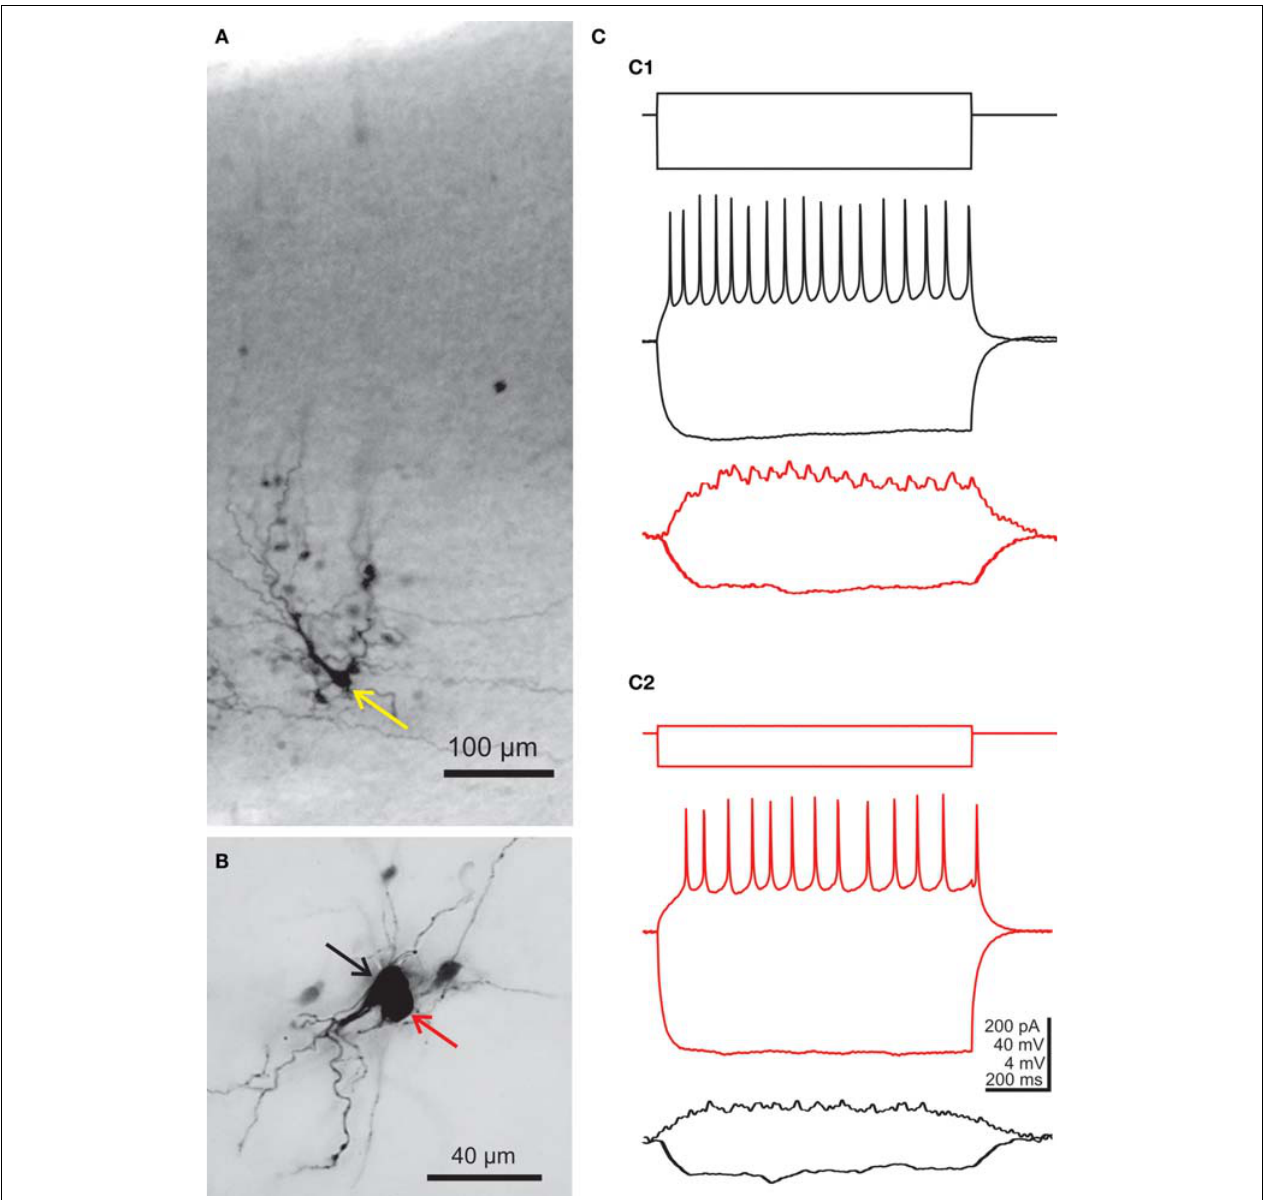
FIGURE 2 | Morphological and electrophysiological evidence for electrical coupling between subplate neurons. (A) Intracellular biocytin staining of one subplate neuron (yellow arrow) in the P3 mouse neocortex results in columnar labeling of several dye-coupled cells in the subplate and in the cortical plate. (B) Photograph of two simultaneously recorded P1 subplate neurons, which were both stained with biocytin. (C) Paired current-clamp recordings of the cells shown in (B) . Black traces were obtained from the cell marked by black arrow in (B) and red traces are from the cell marked by red arrow. (C1) Injection of a